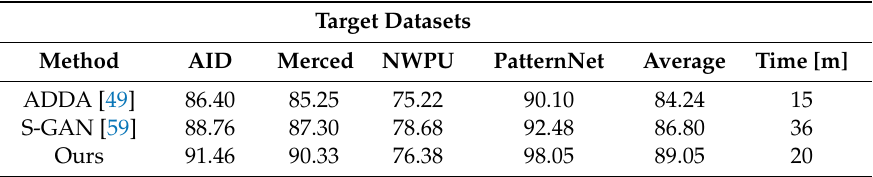
Table 3. Comparisons with respect to state-of-the-art